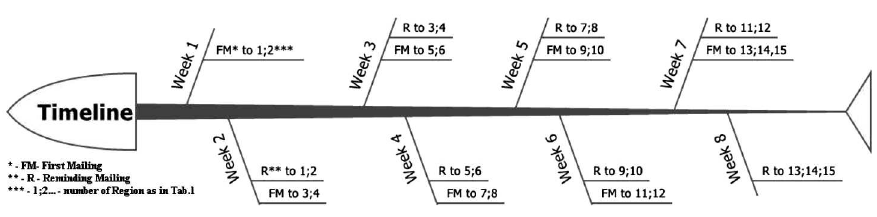
Figure 1. Timeline of the National Study of ICT Use in Primary